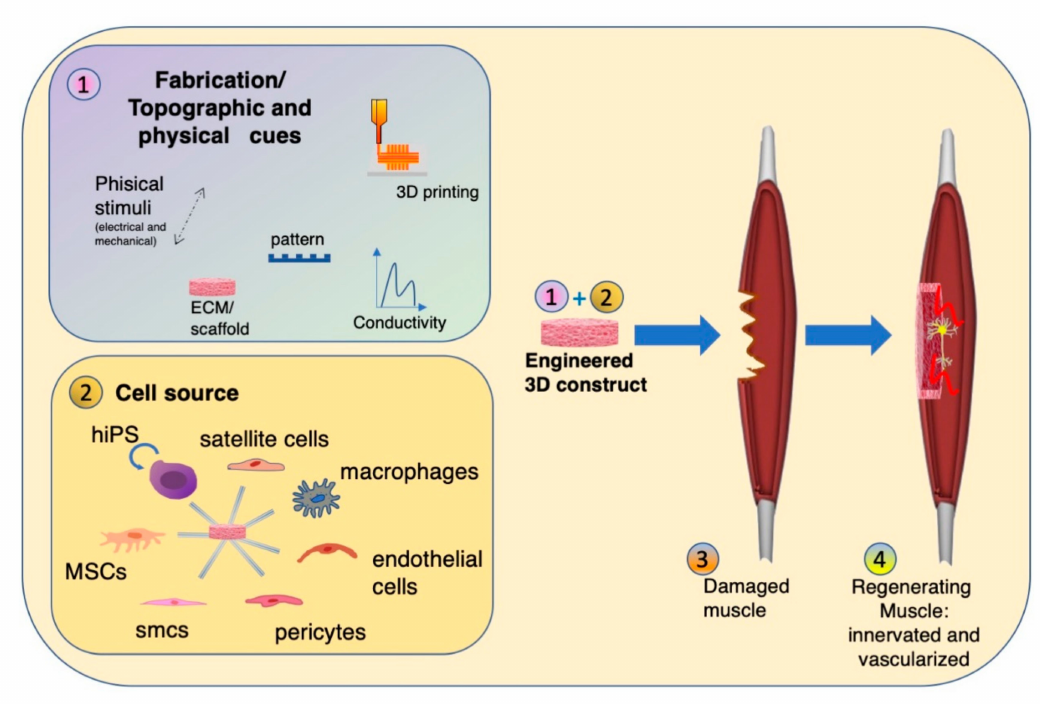
Figure 2. Muscle tissue engineering. (1) Tissue engineering technologies (fabrication / topographic and physical cues) are needed to generate a 3D muscle-like construct together with (2) di ff erent cell types: satellite cells, macrophages, endothelial cells, pericytes, smcs, MSCs. The 3D engineered tissue is applied to a damaged muscle (3) in order to induce muscle regeneration (4), including a functional innervated and vascularized